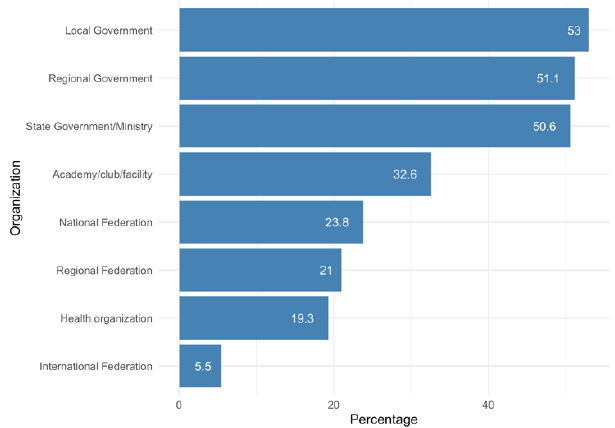
Figure 1. Organizations imposing measures on tennis coaches.